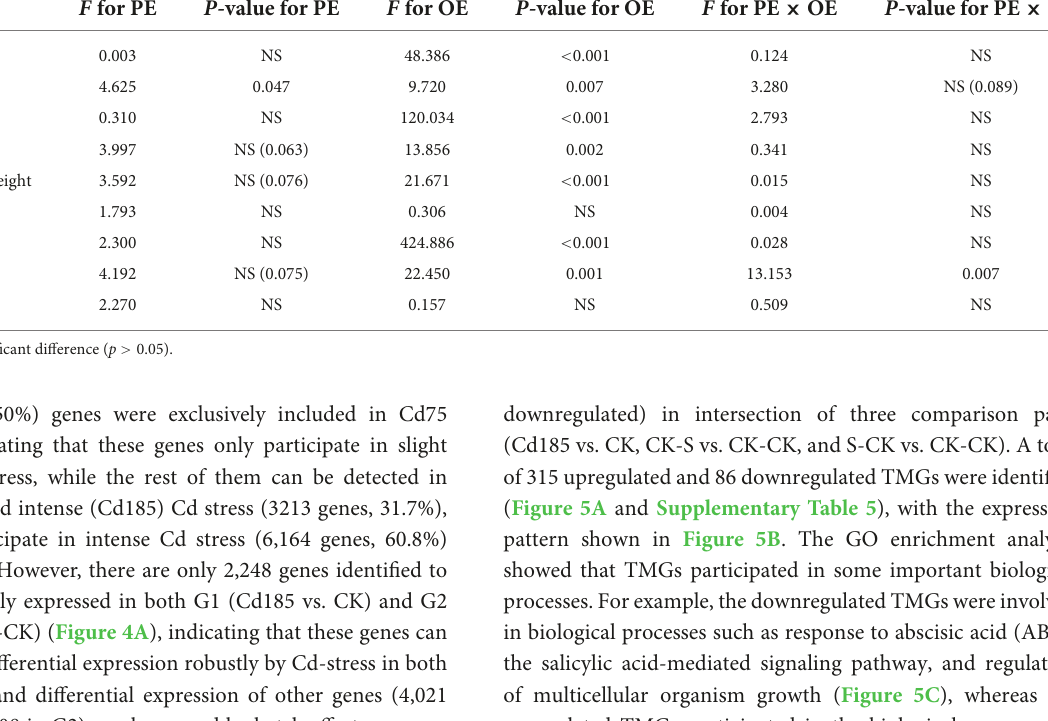
TABLE 1 Effects of the parental environment (PE), offspring environment (OE), and their interactions on traits of field pennycress in generation 2. Source of variation